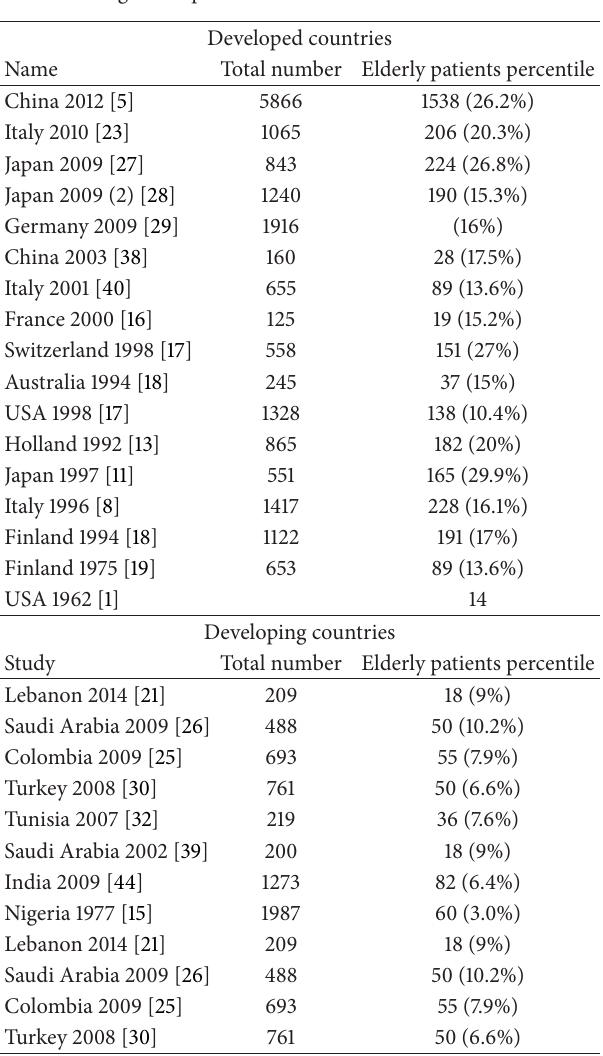
Table 2: Proportion of elderly patients in uveitis epidemiology studies among developed